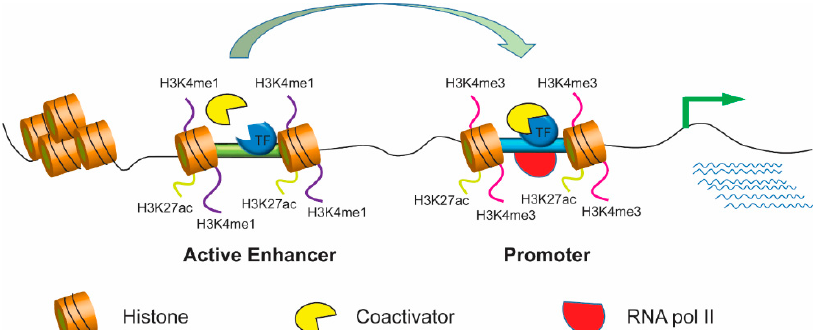
Figure 1. Active enhancers promote high-level gene expression. Epigenetic marks for active enhancers usually include H3K4me1 (monomethylation of H3 lysine 4) and H3K27ac whereas the trimethylation of histone H3 lysine 4 (H3K4me3) is often enriched at gene promoters. The active enhancers regulate gene transcription through chromatin looping with the promoters of target genes. Thus, looping formation eventually contributes to the recruitment of transcription factors, coactivators, and RNA polymerase, promoting high levels of target gene expressions.